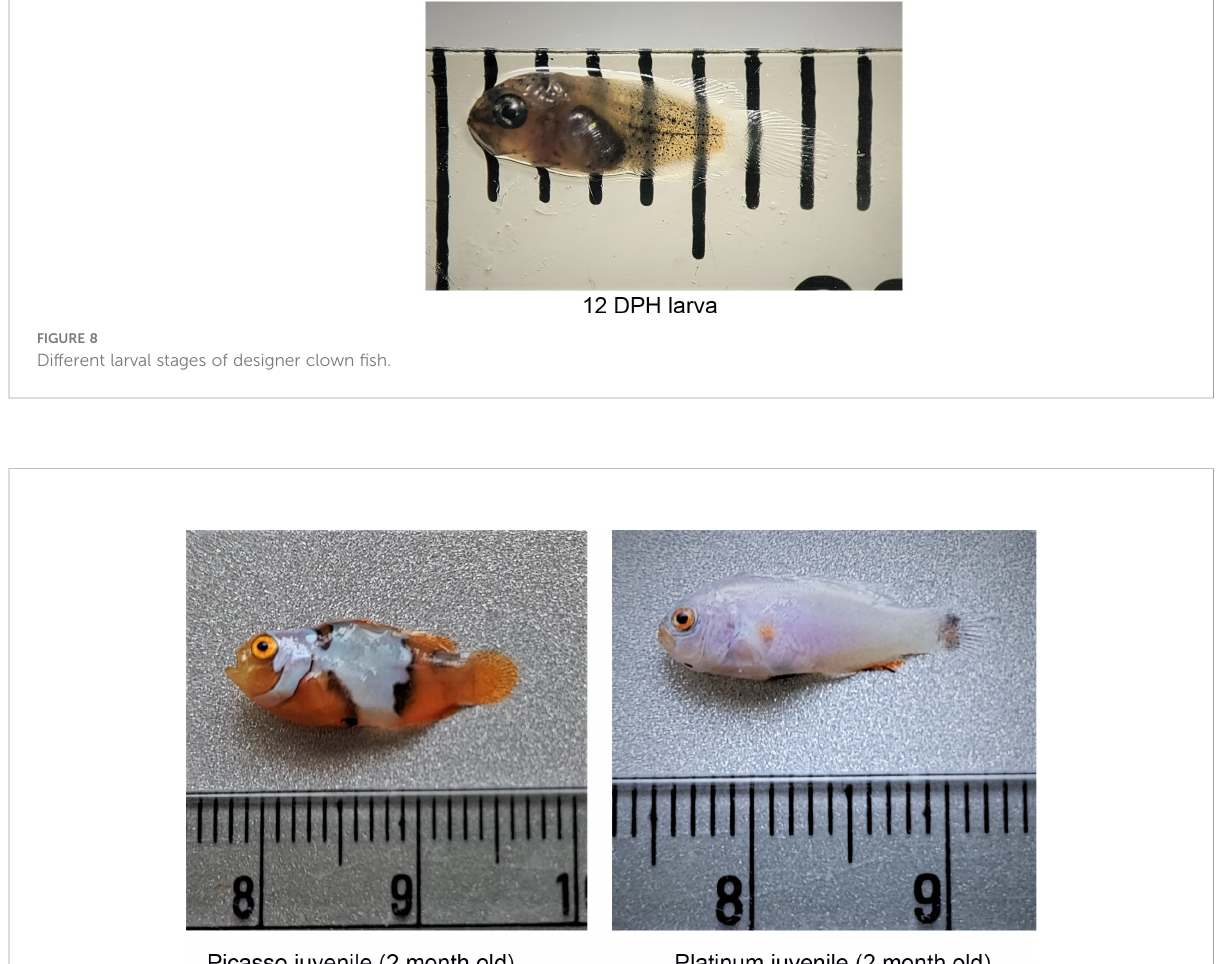
neighbor-joining methods. The tree was rooted in the COI sequence of Dascyllus aruanus . The molecular study revealed that both designer clown fi shes had maximum similarity to A. percula . Hence, the conventional